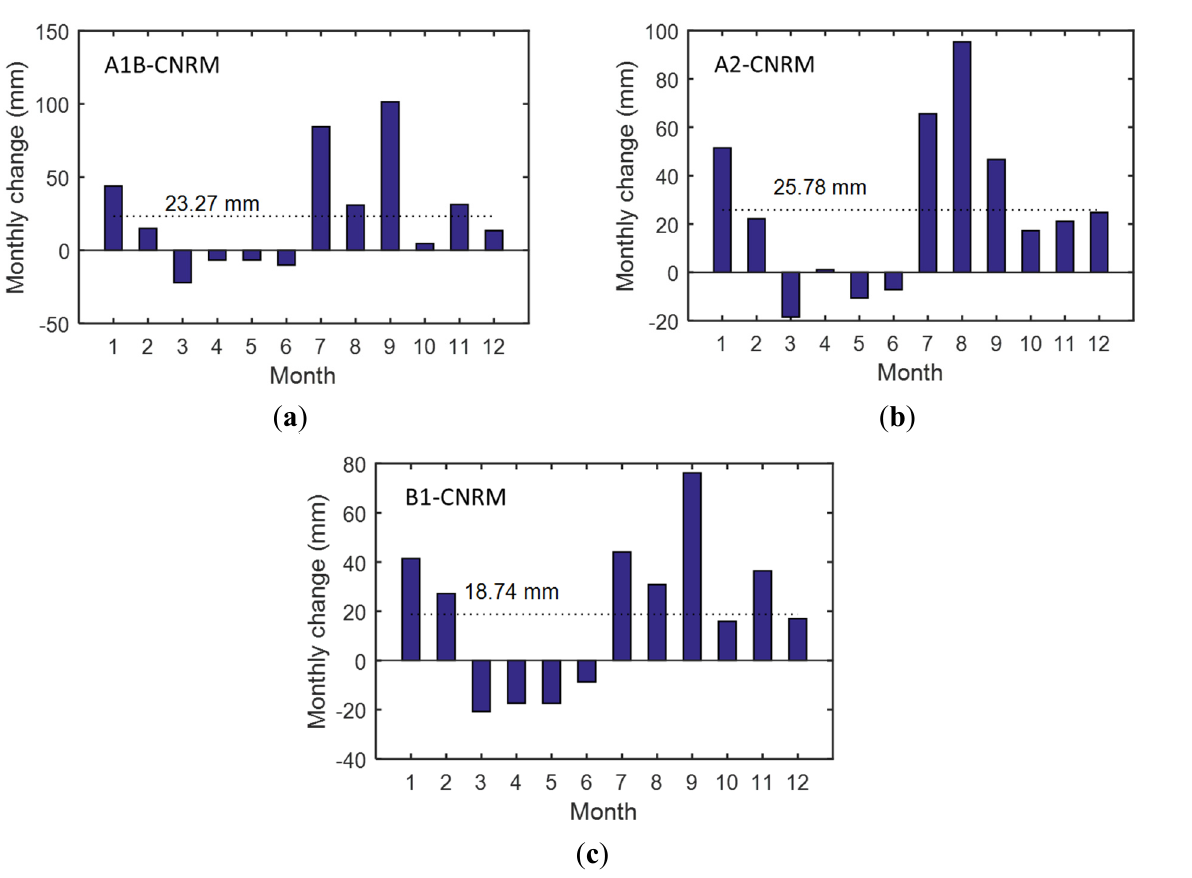
Figure 2. Monthly changes in precipitation under three climate change scenarios of CNRM for the test catchment 1001 during 2070–2099, ( a ) A1B; ( b ) A2 and ( c )